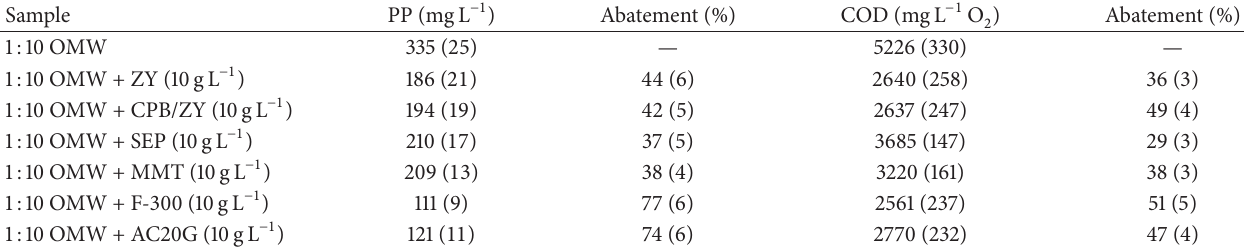
Table 3: PP and COD values in 1: 10 OMW before and after adsorption onto 10g L −1 ZY, CPB/ZY, SEP, MMT, and activated carbons ( 𝑛 = 3 ). Sample